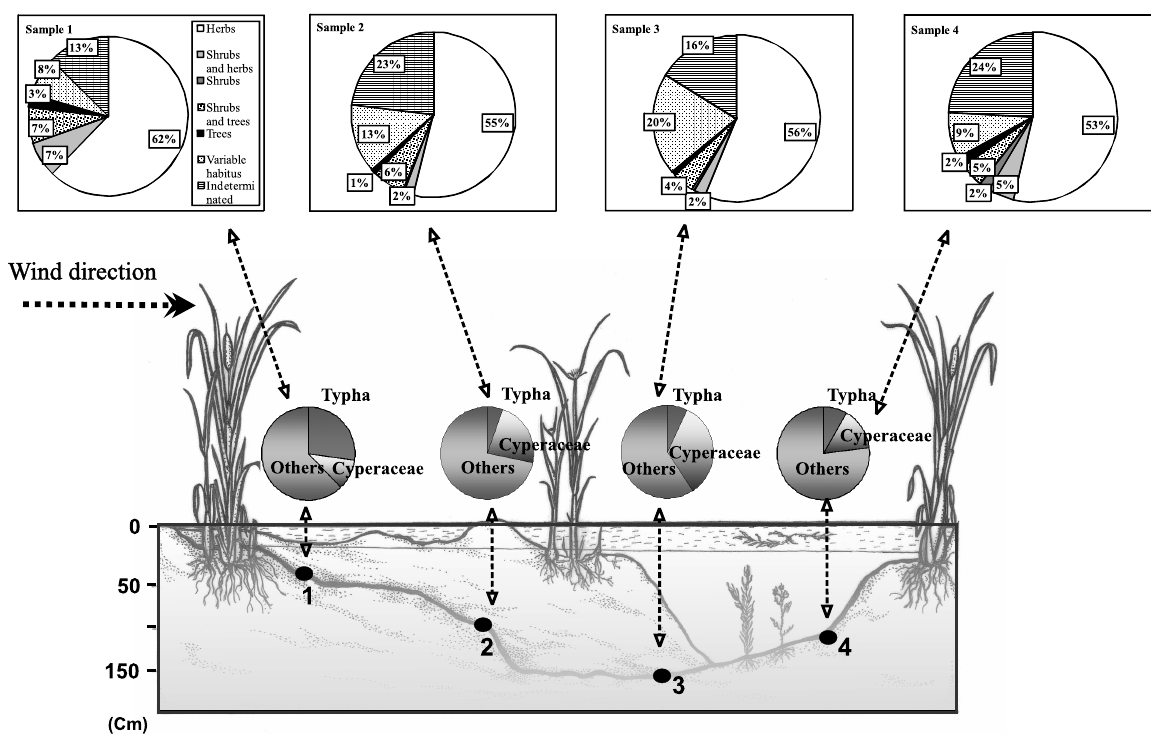
Fig. 5 – Surface samples from the Lagoa do Campelo Lake and frequencies of Typha, Cyperaceae and other pollen grains.